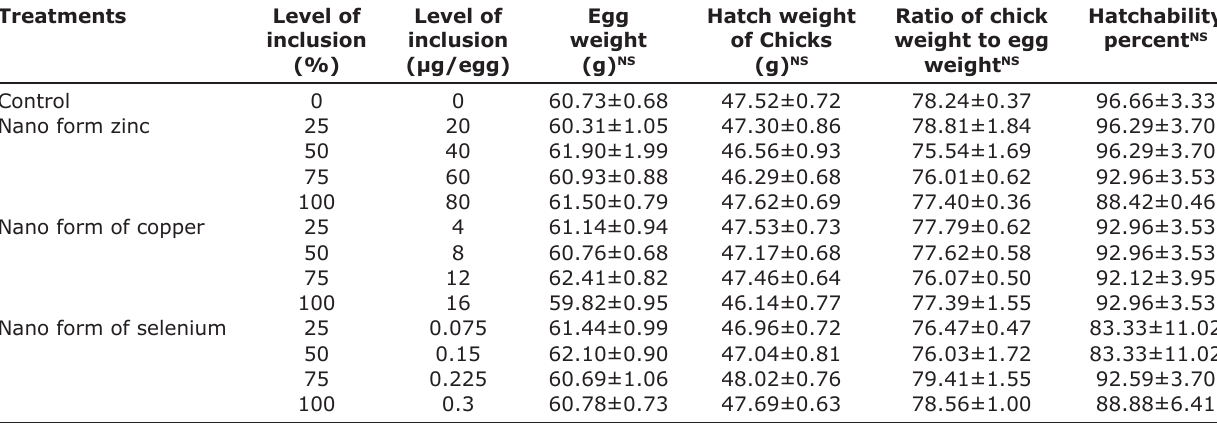
Table-4: Effect of in ovo feeding of broiler eggs with nano form of zinc, copper and selenium at graded levels on egg weight, hatch weight of chicks and their ratio and hatchability percent*. Treatments